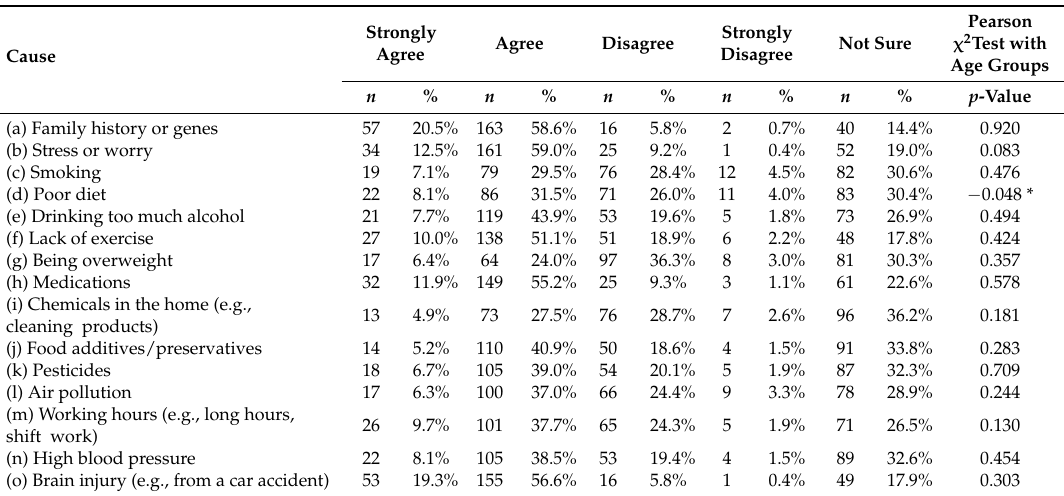
Table 4. Views on the causes of